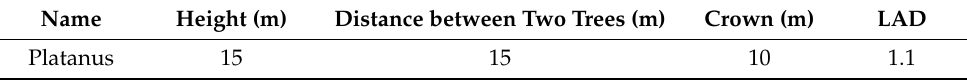
Table 1. The attributes of street tree model.